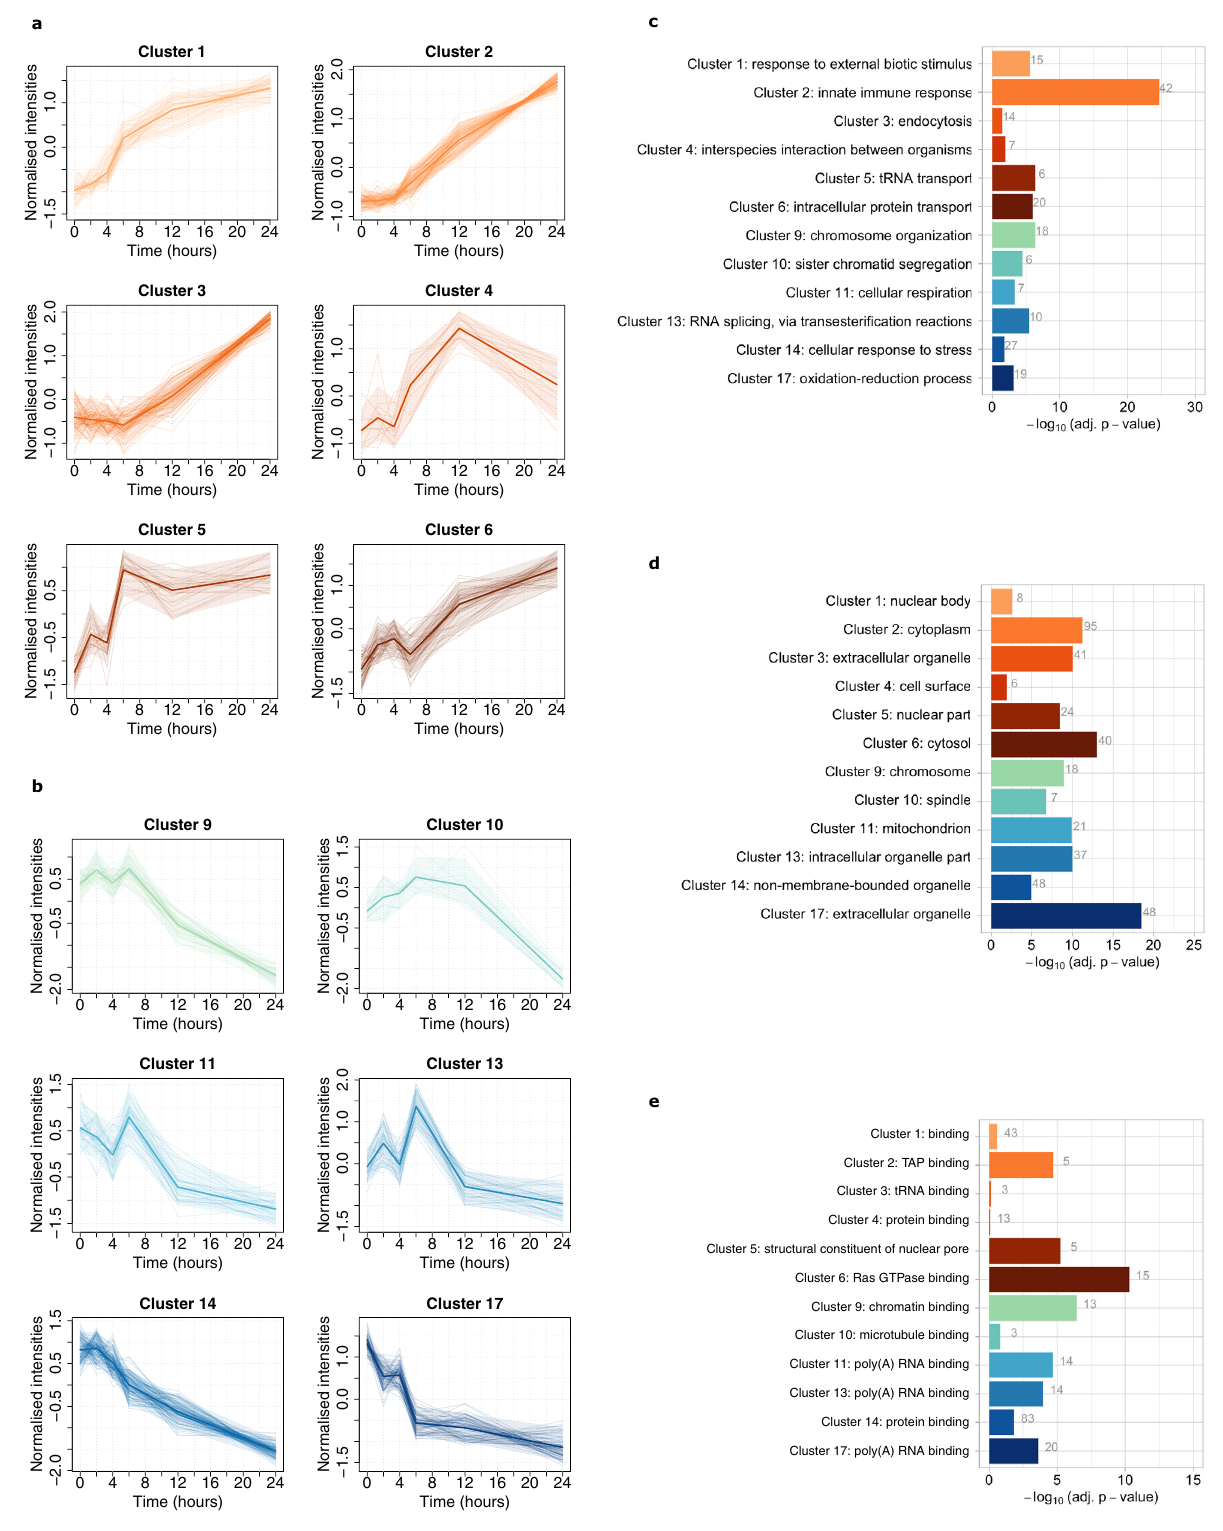
Fig. 3 Bayesian temporal clustering of the LPS time series demonstrates clusters of co-regulated proteins. a Shown are multiple dataset integration (MDI) pro fi les for each protein found in 6 representative upregulated and b 6 downregulated clusters from the Bayesian temporal clustering analysis. The single bold line pro fi le on each plot shows the mean normalised MDI pro fi le and the 0.05 and 0.95 quantiles of each cluster are highlighted by shaded bands. c Gene Ontology Biological Process (GOBP) d Cellular Component (GOCC) and e Molecular Function (GOMF) annotation term enrichment for the clusters are shown. X -axis: – log 10 (adj. p -value). The numbers within the bar charts refer to the number of proteins associated with that term in each cluster. Source data are provided as a Source Data fi